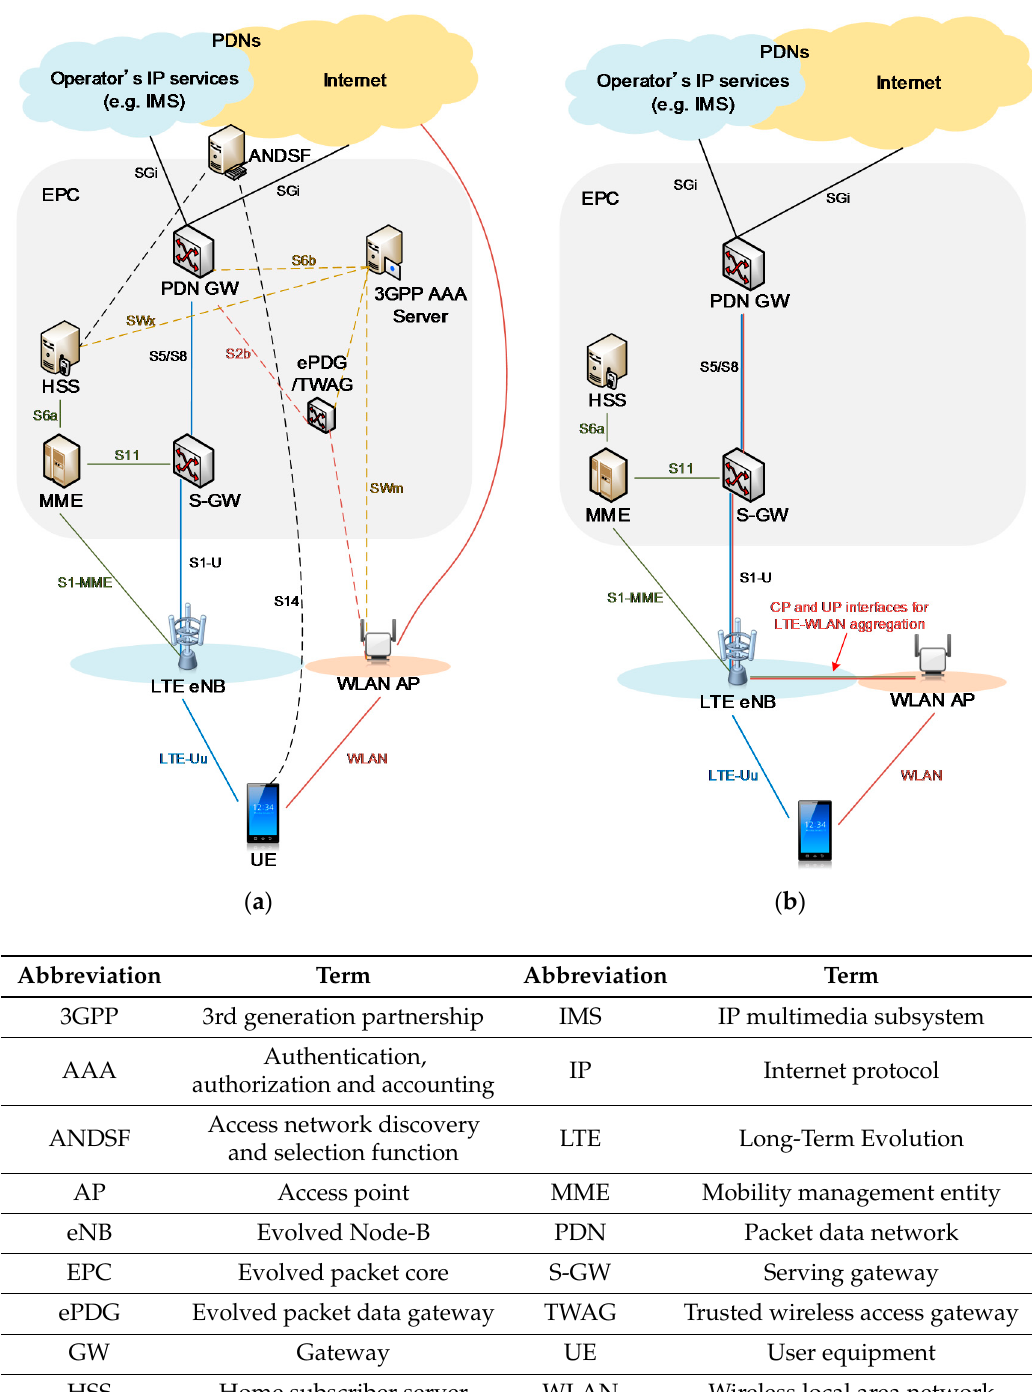
Figure 3. Example LTE-WLAN coordination and integration architectures: ( a ) 3GPP/WLAN interworking architecture and ( b ) LTE-WLAN aggregation.